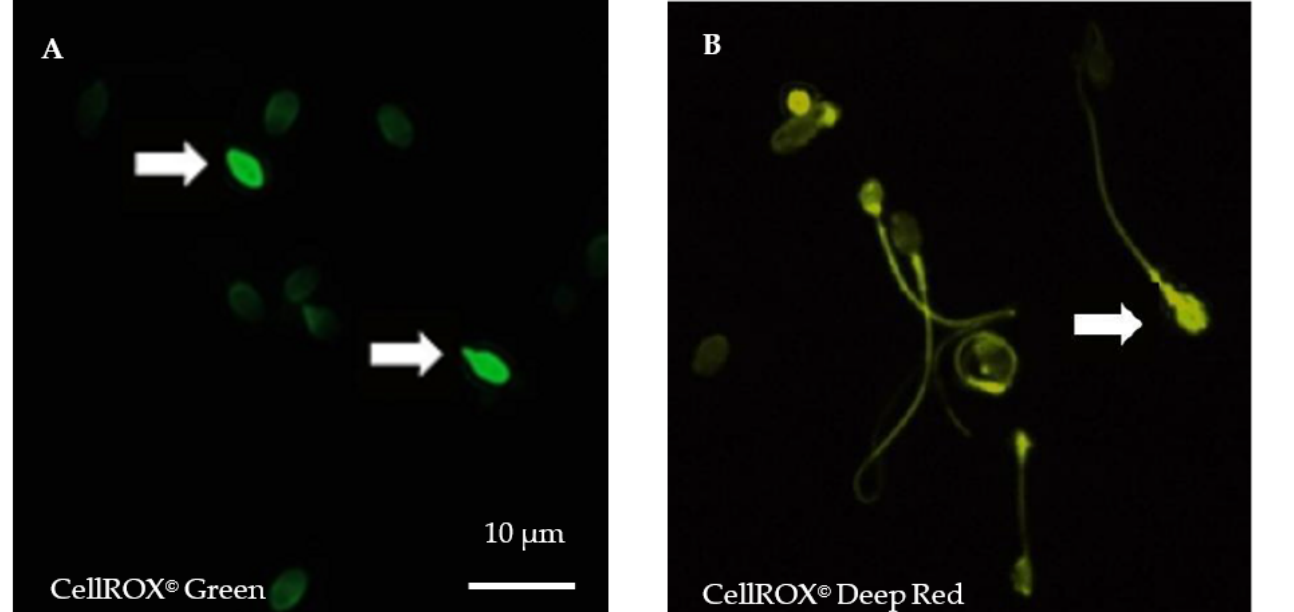
Figure 1. Cytoplasmic and nuclear reactive oxygen species (ROS) detection in spermatozoa after staining using CellROX © fluorescent probes. ( A ). Spermatozoa staining using vital fluorogenic CellROX © Green probes. ( B ). Spermatozoa staining using fluorogenic CellROX © Deep Red probes. In a reduced state, CellROX © probes are non-fluorescent and oxidation triggers a strong fluorescence. Positive, oxidized spermatozoa exhibit strong head fluorescence (white arrows). Midpiece or tail fluorescence is not considered positive. Magnification × 900, exposure time of 800 ms, acquisition with Bioview Duet v2.3 image analyzer (Nes Ziona, Israël).